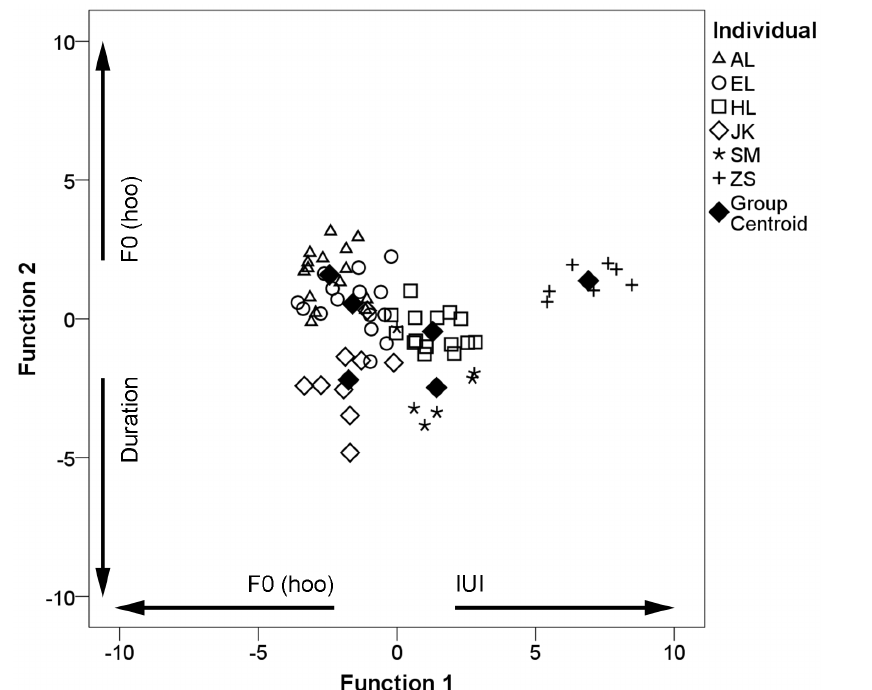
Figure 5. Discriminant scores for loud calls produced by different individuals for the first two canonical discriminant functions. The six males are denoted by different symbols. Variables showing loadings with an absolute value . 0.4 for each function are indicated along the axes.